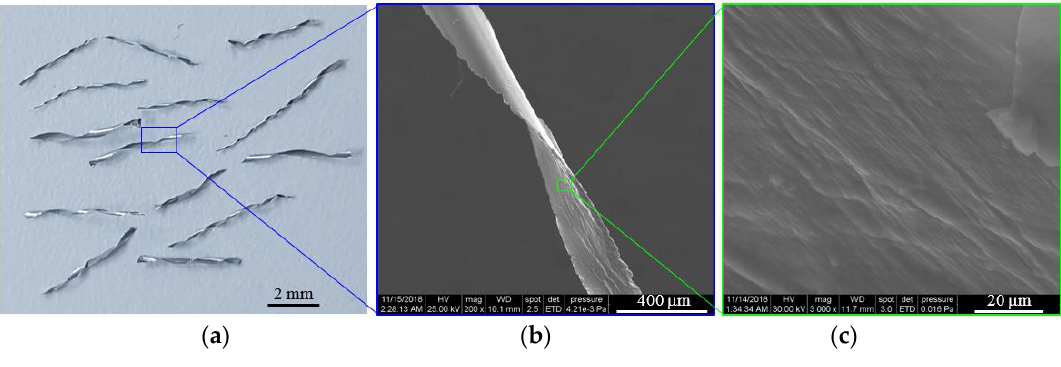
Figure 1. Optical ( a ) and SEM images ( b , c ) of AMs.